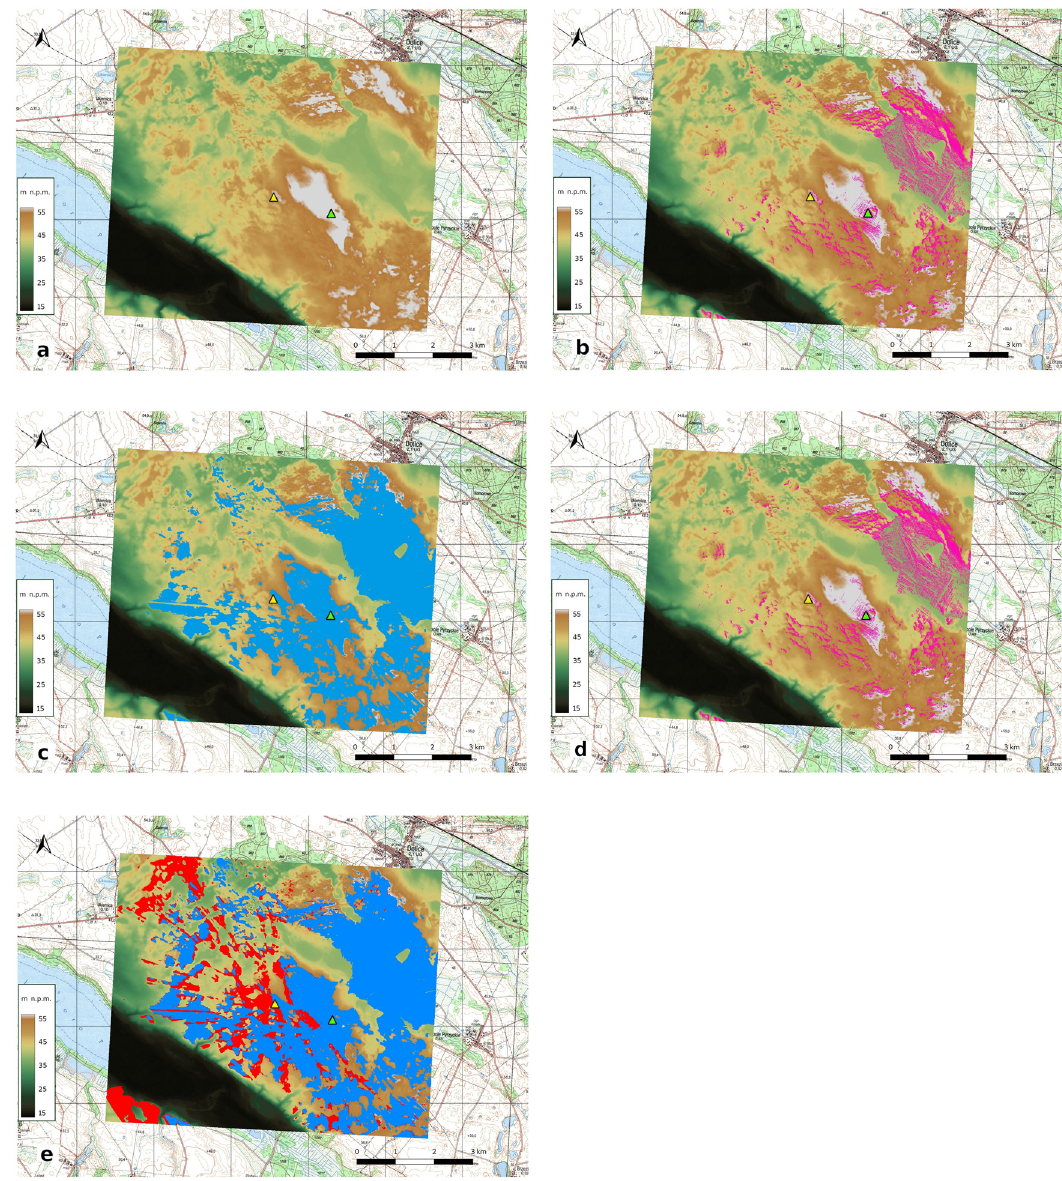
Figure 5: The point selected as optimal near the tomb at Karsko [ yellow triangle ] in terms of visibility from this location and this location from the surrounding area: location of the point [ green triangle ] ( a ) , the area visible from the point ( b ) , the area from which the point is visible ( c ) , the juxtaposed areas visible from the point and the tomb at Karsko ( d ) and the juxtaposed areas from which the point and the tomb at Karsko are visible ( e ) ( M. Schiller )